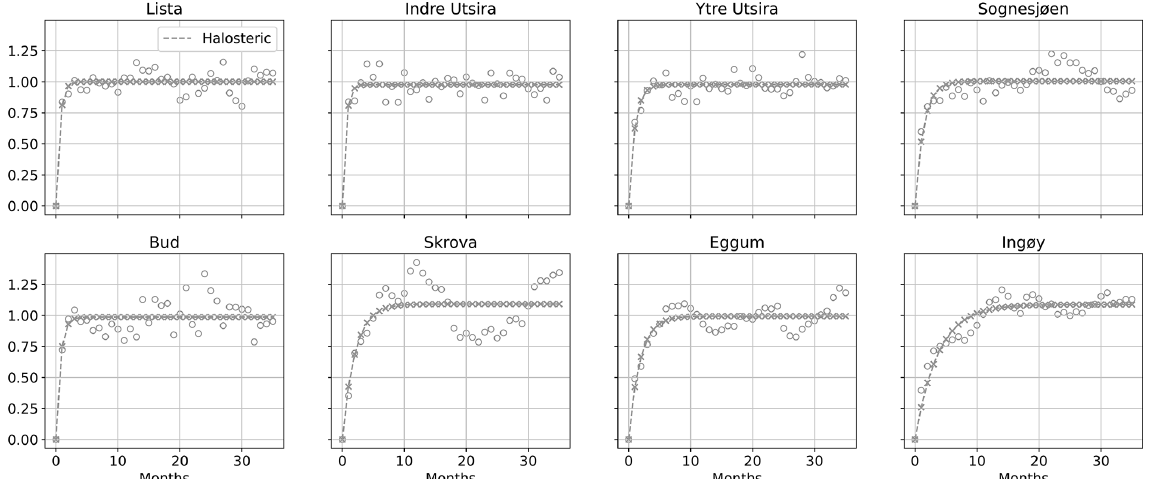
Figure B2. For each hydrographic station along the Norwegian coast, semi-variogram of the detrended and deseasoned halosteric component of the sea-level variability (empty circles) and corresponding fit (crosses connected by a dashed line). At each hydrographic station location, we scaled each semi-variogram by the variance of the corresponding detrended and deseasoned halosteric component of the sea level for all the plots to have the same limits on the y axis.